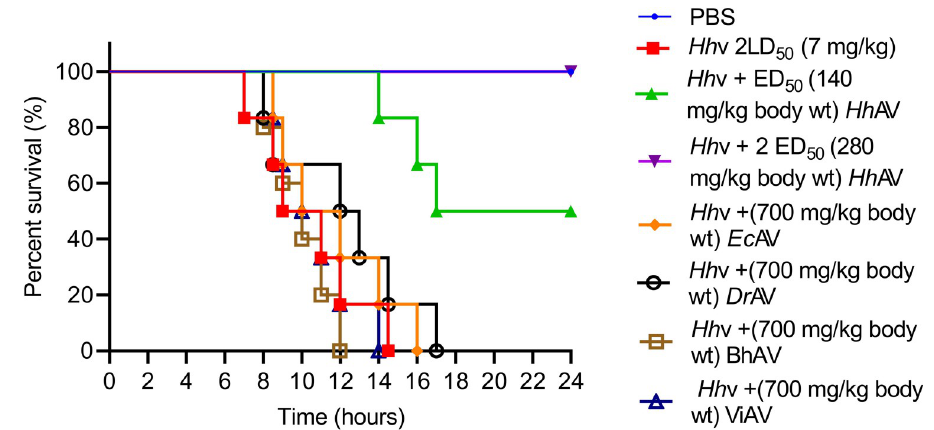
Fig 10. Neutralization of H . hypnale venom lethality by anti-venoms using the murine model. Groups (n = 6) of mice were independently injected intraperitoneally (i.p.) with 2 LD 50 (7 mg/kg) dose of Hh v in 50 μ l of PBS. Post 10 min of venom injection, the mice were administered with ED 50 (140 mg/kg), and 2 ED 50 (280 mg/kg) doses of Hh AV, and 700 mg/kg body weight of Ec AV, Dr AV, BhAV, and ViAV independently via tail vein (i.v.). Groups of mice that received venom alone and PBS were served as control experiments. Mice were kept under observation for 24 h and the time of death was recorded. The percent survival analysis of mice was done by constructing the Kaplan-Meier survival curve, the p -value was calculated using the log-rank (Mantel-Cox) test, ��� p < 0.001, and ���� p < 0.0001.